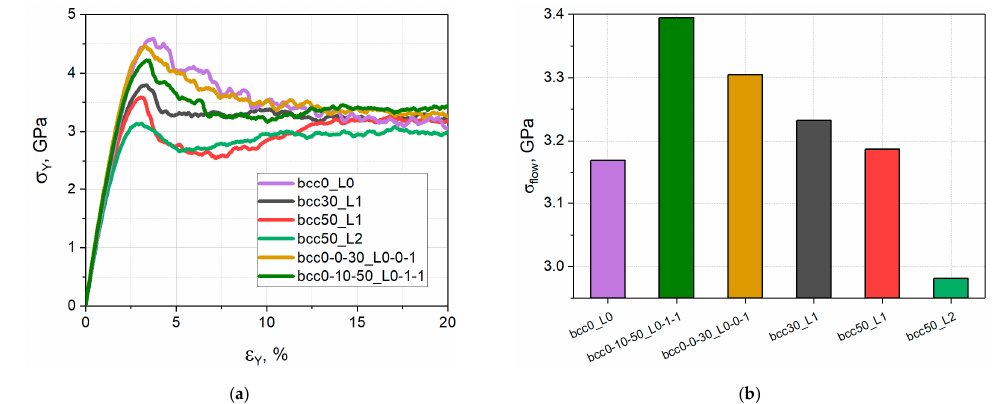
Figure 21. Stress–strain dependence ( a ) and yield stress in the strain range 17.5–20% ( b ) for different samples under tension. Cross-sections of different layers of the simulated samples are shown in Figure 22. Small-grained layers of the samples have a qualitatively similar structure. Differences be- come evident in medium-grained layers and are significantly enhanced in large-grained layers. This is due to the fact that thicker lamellae in the bcc50_L1 sample (middle column in Figure 22) are transformed into subgrains, causing grain fragmentation. Thinner lamel- lae of the bcc50_L2 sample (right column in Figure 22) in tension are transformed in such a way that their structure coincides with the fcc lattice of the host grain. Medium grains